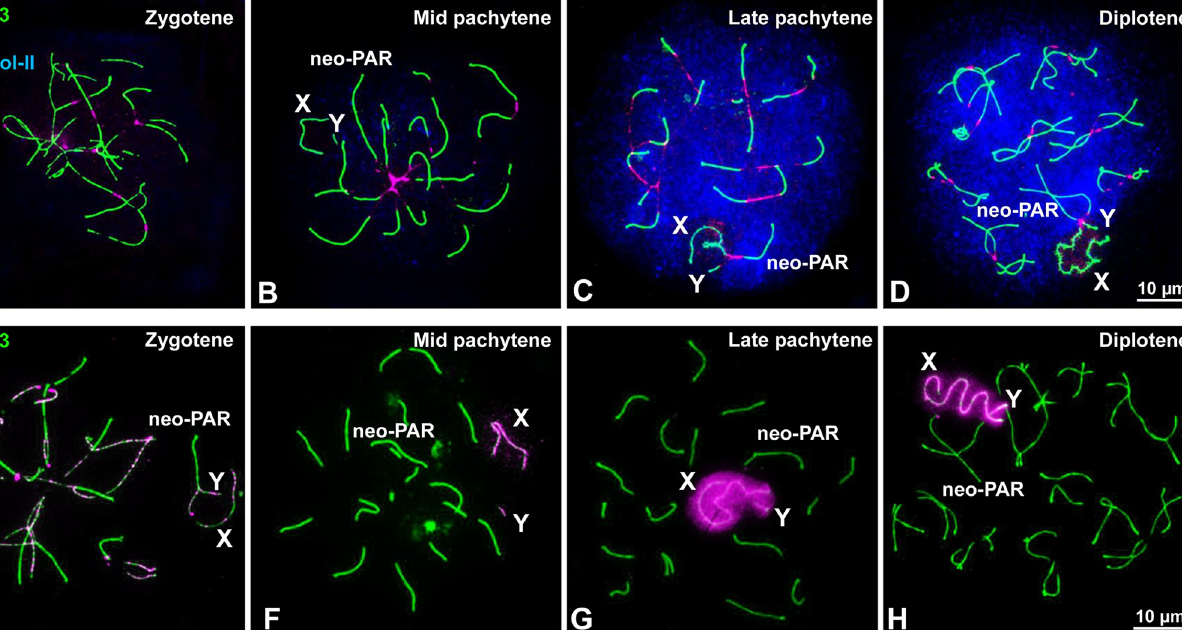
PLOS Genetics | https://doi.org/10.1371/journal.pgen.1008959 November 12,